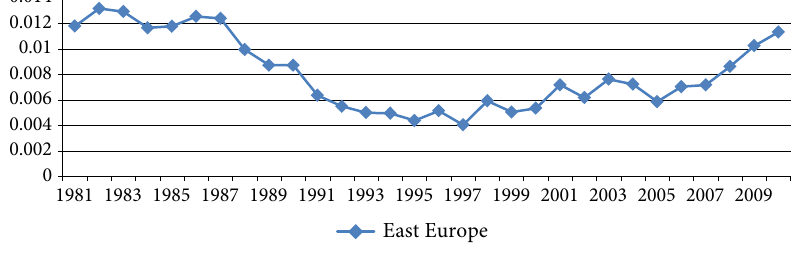
Fig. 2. Knowledge gap between East European countries and the US Note : see Table 1.